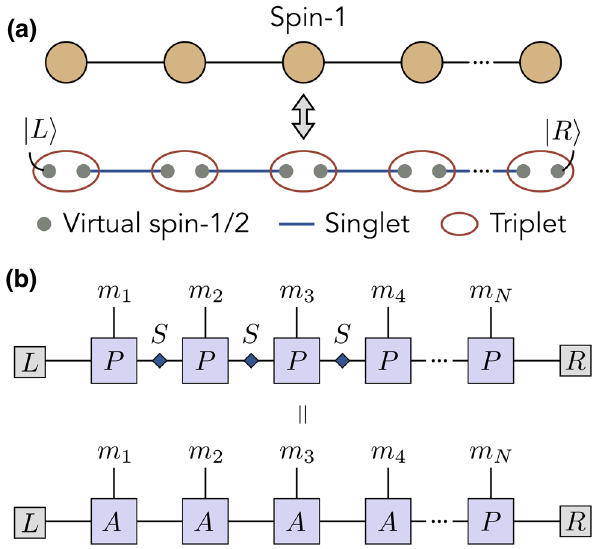
FIG. 1. (a) An illustration of the spin-1 AKLT state as a valence-bond solid. The ground state of the AKLT state is most intuitively constructed by considering each spin-1 site as being composed of virtual spin-1/2 pairs (gray circles), with intersite pairs in the singlet state and intrasite pairs projected onto the triplet subspace. (b) A diagram of the MPS representation of the AKLT state, with left and right boundary conditions | L (cid:3) and | R (cid:3) corresponding to the state of the free edge qubits. For each ten- sor, vertical legs represent physical indices and horizontal legs represent virtual indices. The connected horizontal lines between adjacent tensors indicates